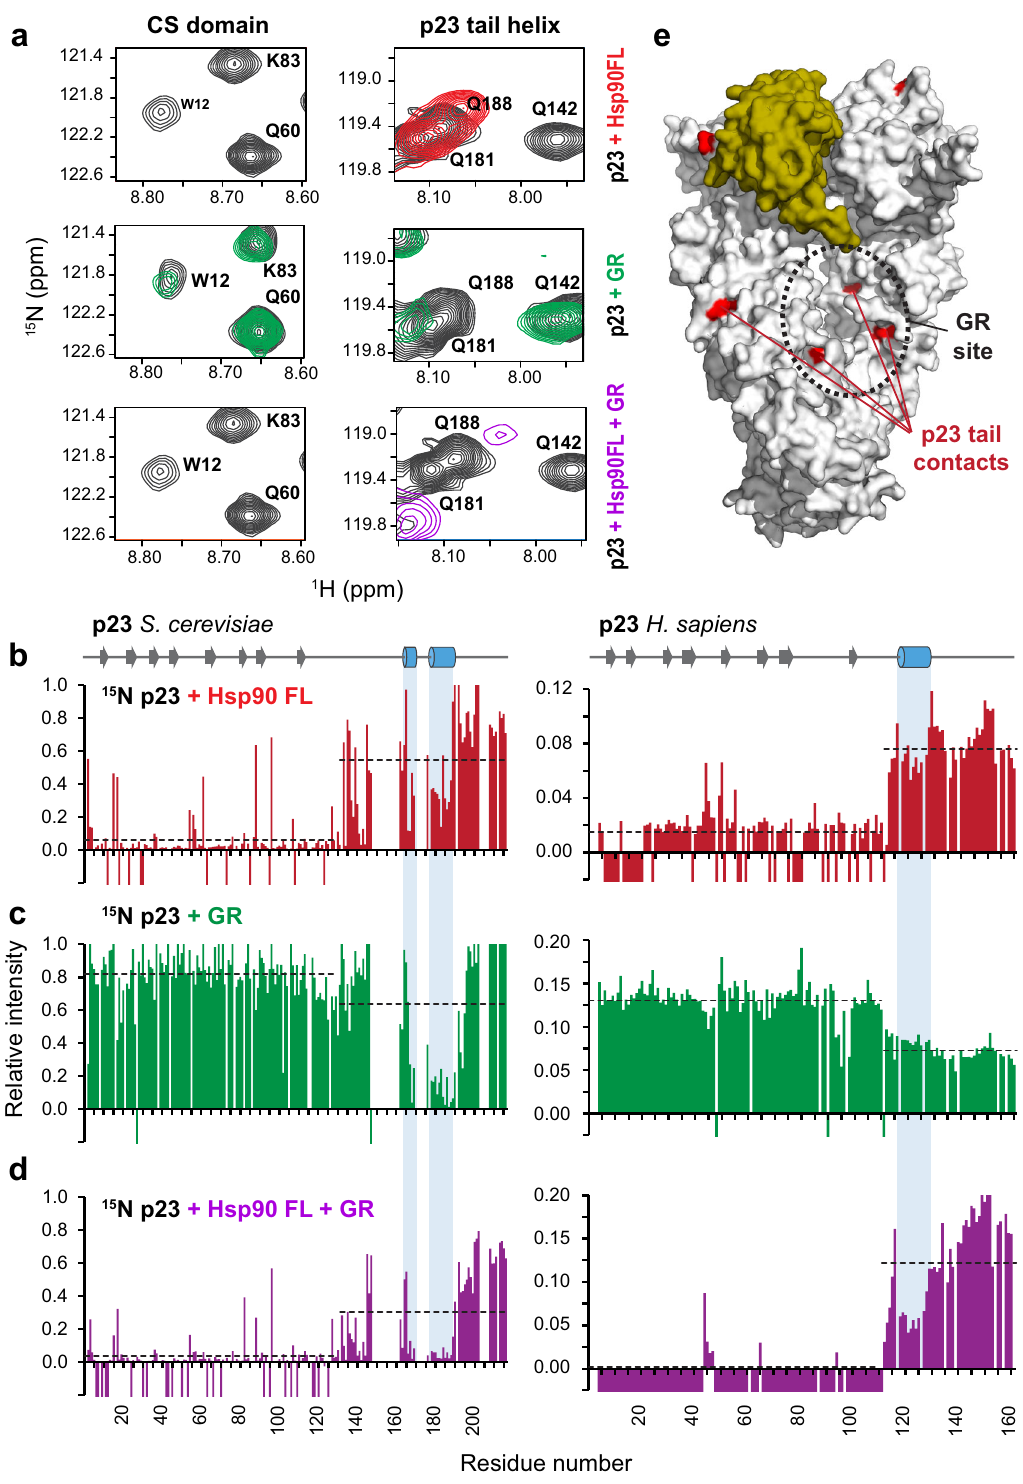
Fig. 5 NMR analysis of 15 N-labeled p23 in the presence of Hsp90/AMP – PNP, and/or GR. a Zoomed view of 1 H- 15 N HSQC NMR signals in the CS domain and the helical motif in the p23 tail comparing p23 free in solution (black), in the presence of Hsp90 FL (red), GR-LBDm (green) or Hsp90 FL and GR- LBDm (purple). Intensity ratios of p23 peaks in the absence and in the presence of ( b ) full-length Hsp90 (FL), ( c ) the GR ligand binding domain (GR- LBDm), or ( d ) Hsp90 FL and GR-LBDm, for yeast (left) and human (right). Negative bars indicate resonances broadened beyond detection; the average peak intensity for the p23 core domain and the C-terminal tail is shown as a dashed line. Secondary structure elements are shown at the top, highlighting the helical motifs in the p23 tail. e Binding sites of the p23 tail and GR interactions with the Hsp90 dimer overlap at the MC